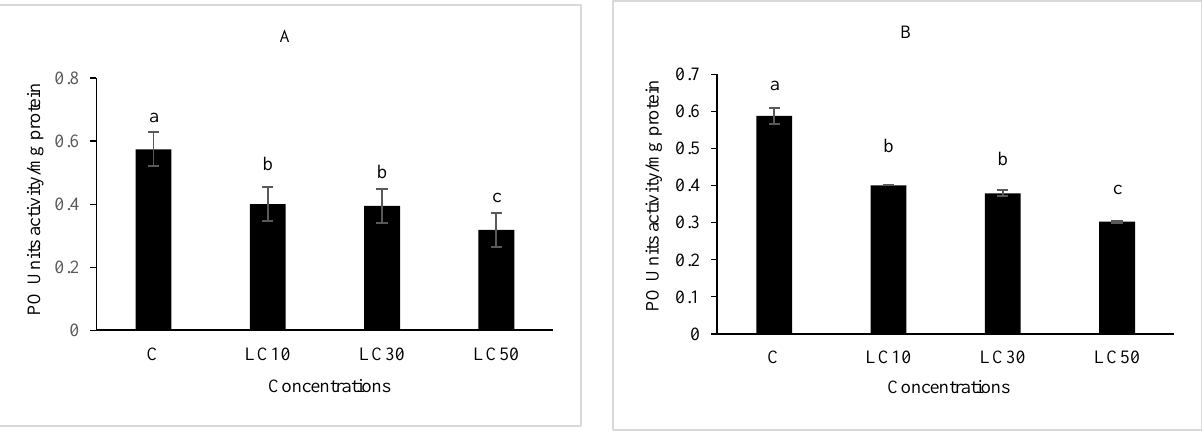
Figure 4. The effect of Artemisia annua floral essential oil on phenol oxidase (PO) activity of Glyphodes pyloalis larvae treated with oral ( A ) and fumigant ( B ) assays. Bars with different letters above them indicate significant differences between means at p < 0.05, Tukey’s test. The number of hemocytes ×10 4 .